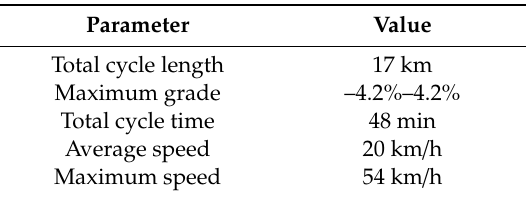
Table 2. Round trip main data.